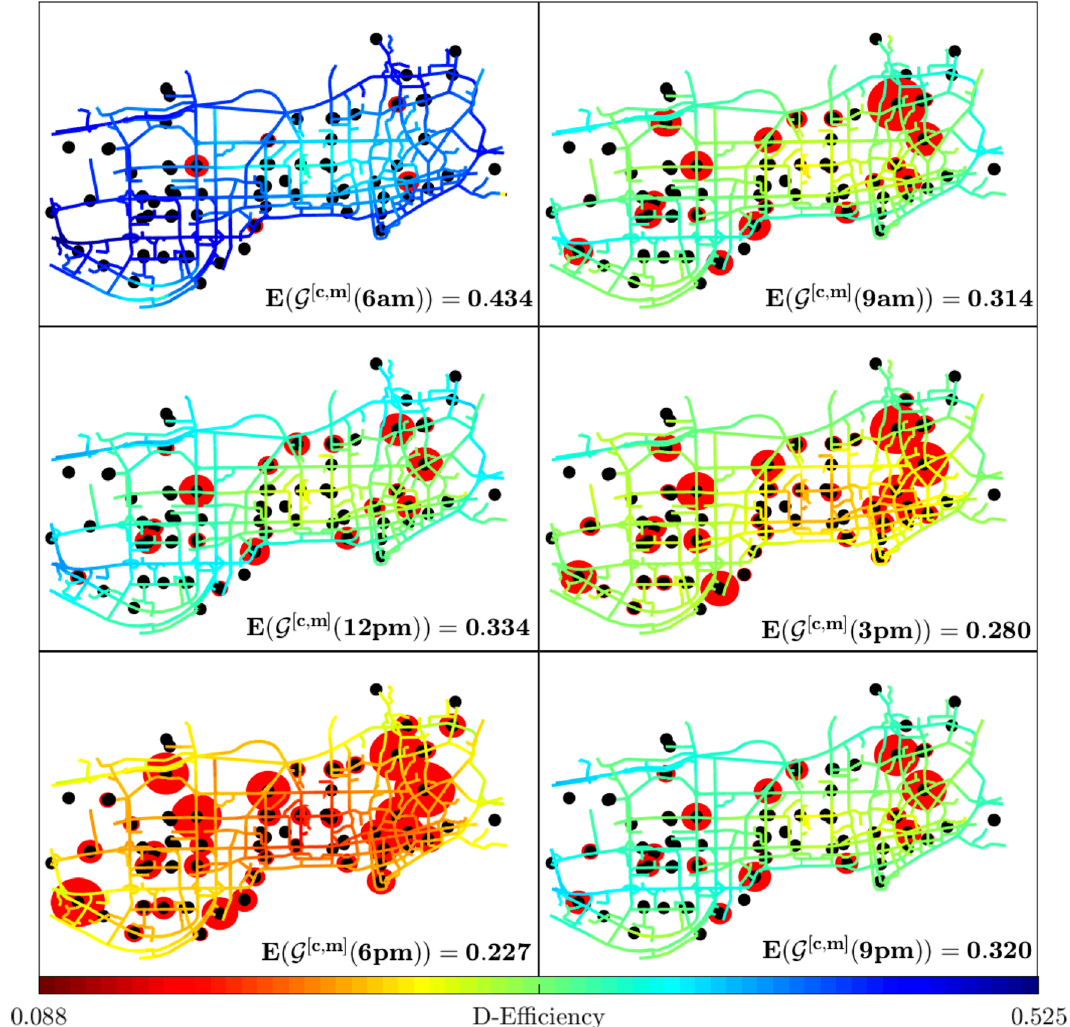
Figure 3. Daily variations of road efficiency and station centrality. The spatial patterns of road efficiency are shown at six different times of the day (from 6 a.m. to 9 p.m., every 3 h) for the city of Shenzhen (same day as in Fig. 2.) The color on each link stands for the efficiency of the corresponding road, from a minimum value of E = 0.088 in dark red, to a maximum value of E = 0.525 in dark blue. The center-east and the south-west parts of the network are those experiencing the most severe congestion, especially at rush hours. In the same map, the size of the red circles around the intermodal stations (black points) are proportional to the values of station centrality as defined in Eq. (6). We notice that the nodes with the highest station centrality are not inside, but around the congested areas of the Figure 5 represents the average of the β ∗ − (Fig. 5a) and α ∗ − (Fig. 5b) dilemma factors during the day and the relation between these two measures. One can notice that both quantities change significantly only during the evening peak hour where the severity and the spatial distribution of traffic becomes critical. There exists a strong dependence between these two factors during the whole day and the congestion grows that we pointed out in Fig. 5c to be linear for small β . The slope of this dependence, that we indicate with Ŵ(α ∗ , β ∗ ) , stands for the influence that the congestion has on the dilemma factors. In particular, it is the variability, due to the con- gestion, of the α ∗ -dilemma factor (number of close stations) over the β ∗ factor (extra-time flexibility to have β ∗ paths options). So, we claim that Ŵ evaluates the multilayer network not in terms of the efficiency (shortest travel times) but in terms of richness of close alternatives to the best H-path in all traffic conditions. The higher the Ŵ , the more the choice when congestion arrives with fixed users’ flexibility. Figure 5c shows that the relation